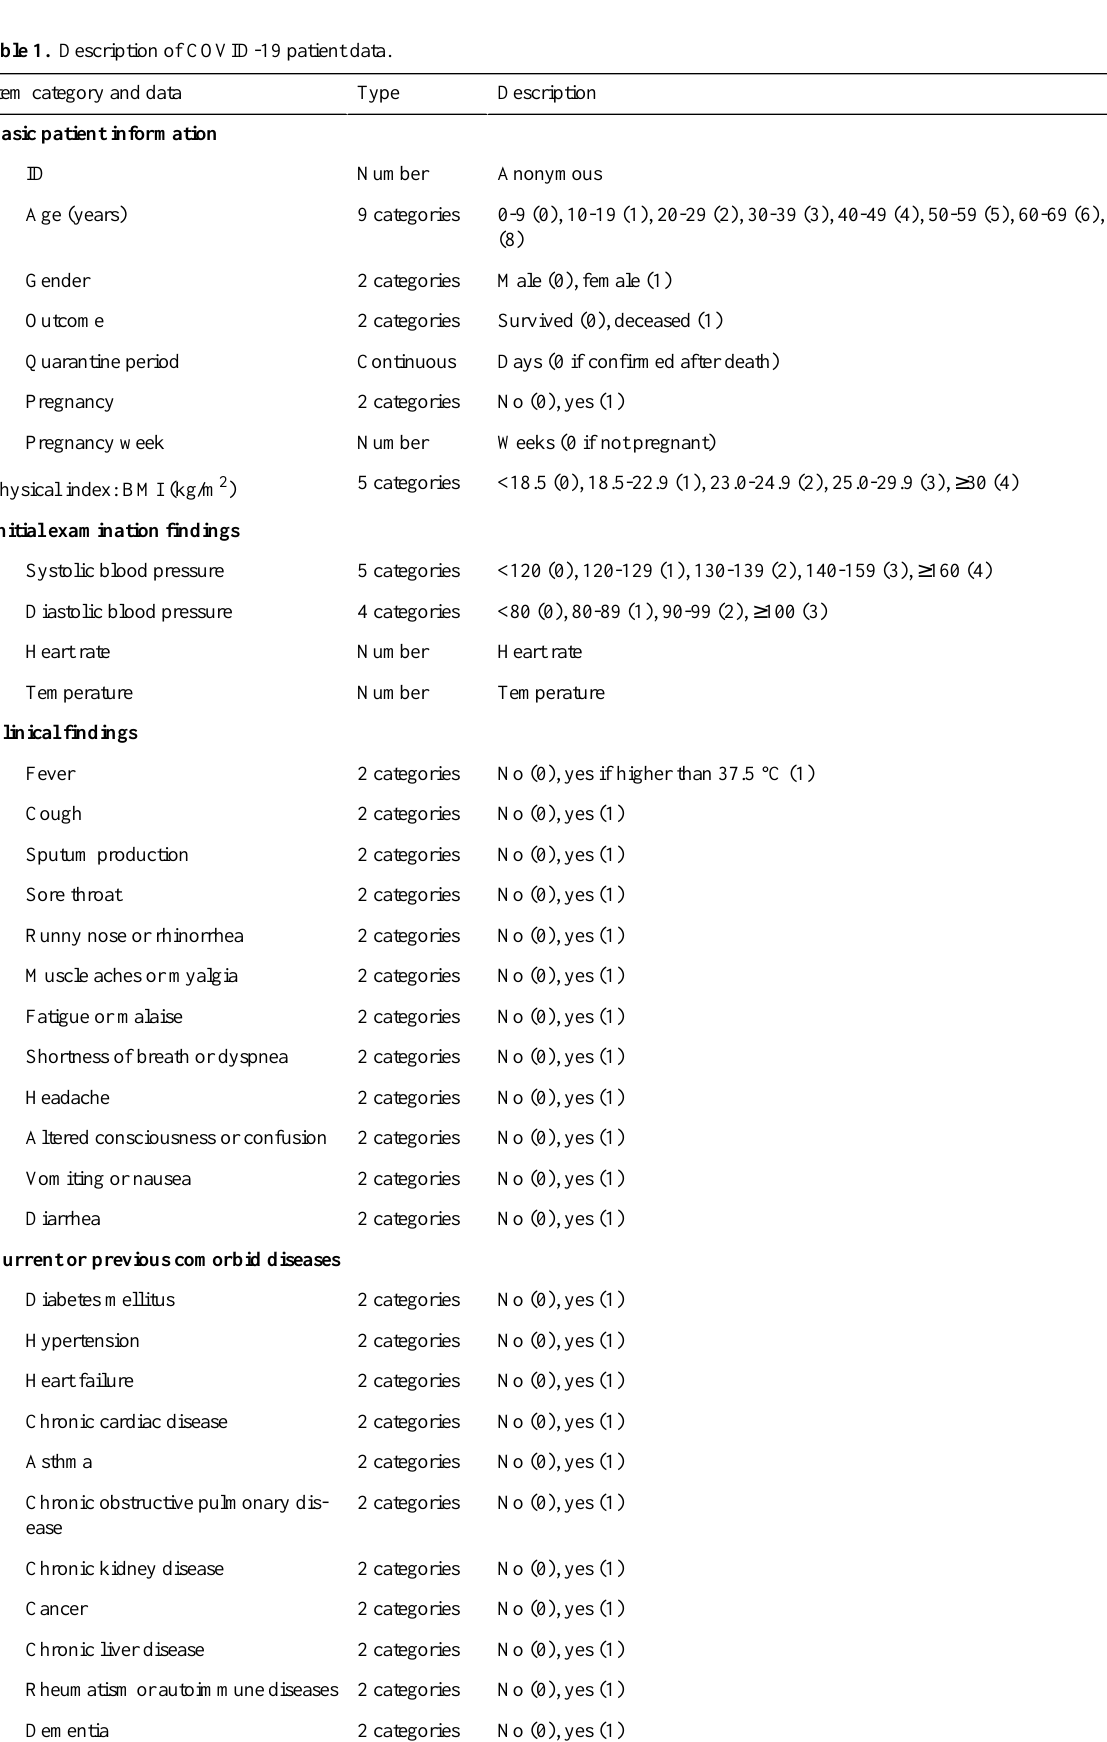
Table 1. Description of COVID-19 patient